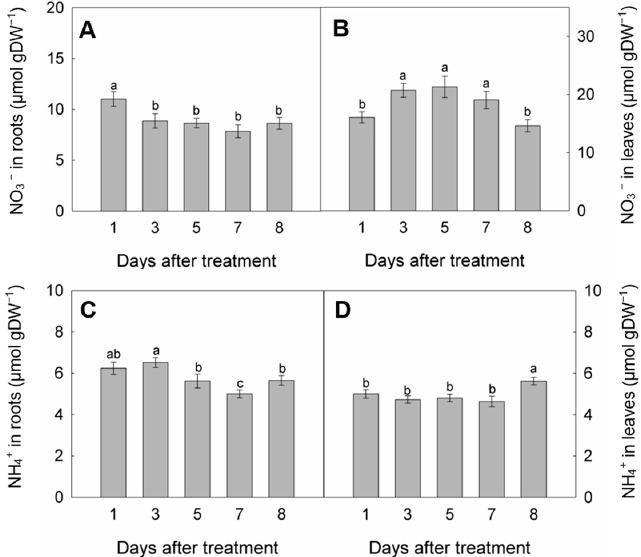
Figure 2. The effect of drought and rewatering on the content of NO 3 − ( A , B ) and NH 4 + ( C , D ) in leaves Figure 2. The e ff ect of drought and rewatering on the content of NO 3- ( A , B ) and NH 4+ ( C , D ) in leaves and roots of Malus hupehensis plants. Bars labelled with different letters indicate significant difference. and roots of Malus hupehensis plants. Bars labelled with di ff erent le tt ers indicate signi fi cant di ff er- ence.